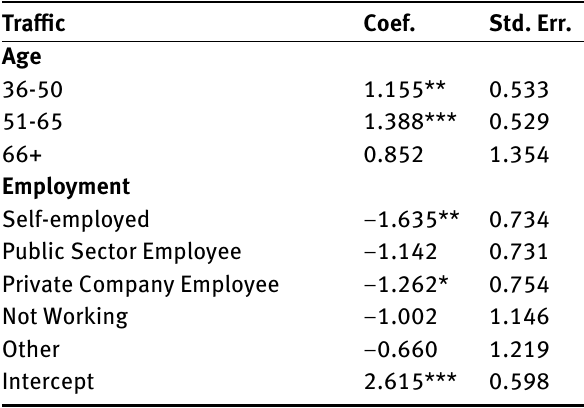
Table 16: Coeflcients of the model for the traflc noise Traflc Coef. Std. Err.